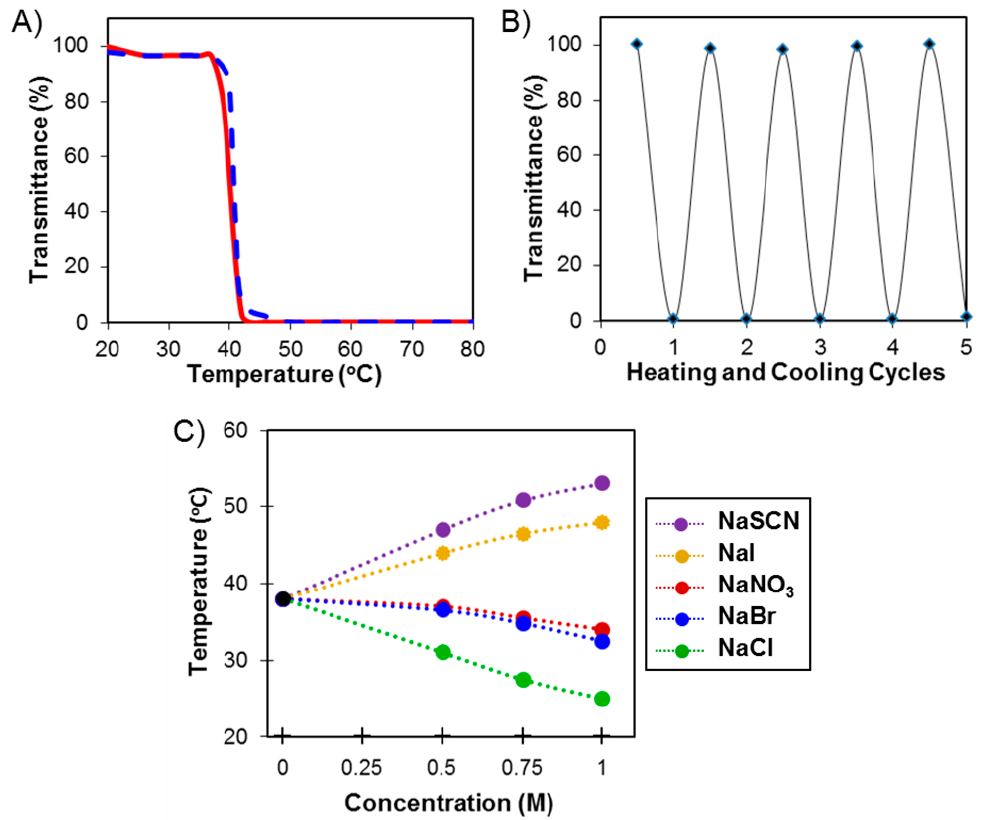
Figure 10. ( A ) Influence of temperature on light transmittance (500 nm) through a sample of aqueous poly(OEG 4 -CH) 150 . Solid red line = heating; dashed blue line = cooling; 1 ◦ C/min. ( B ) Reversible change in optical transmittance of aqueous poly(OEG 4 -CH) 150 when temperature was alternated between 30 ◦ C (high transmittance) and 45 ◦ C (low transmittance); 5 min per each heating/cooling cycle. ( C ) Cloud point temperatures of poly(OEG 4 -CH) 150 measured in different Hofmeister salts (Na + counterion) at concentrations up to 1.0 M. All poly(amino acid)s were prepared at 3 mg/mL. Reproduced with permission [28]. Copyright 2014, American Chemical Society.